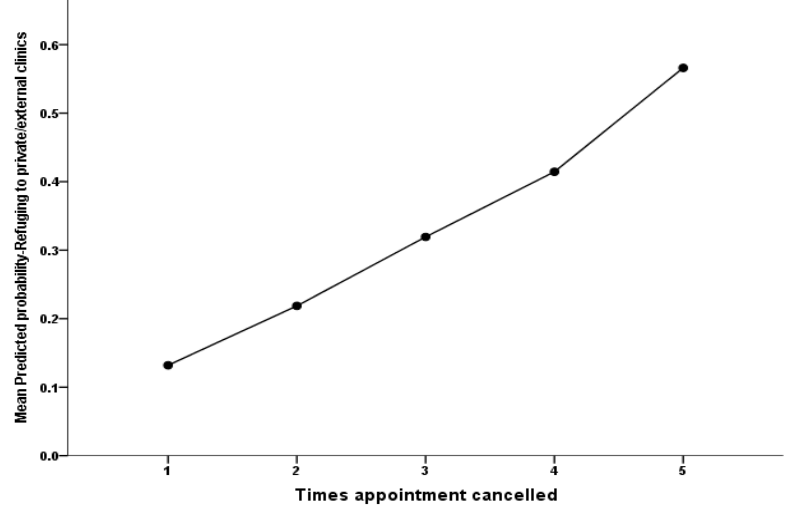
Figure 1. The association between the patients’ number of postponed appointments and their model of predicted mean probability of referring to external of predicted mean probability of referring to external services.